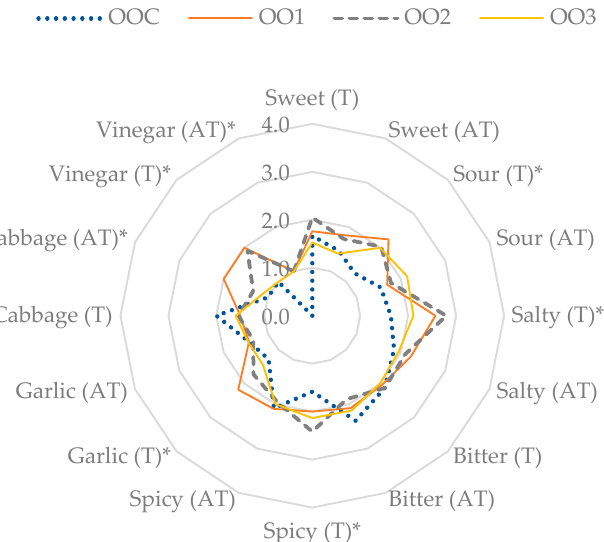
Figure 2. Sensory attributes of taste (T) and aftertaste (AT) of salt and equivalent salt of sauerkraut juice powder in samples with olive oil. * These tastes and aftertastes represent significant differences ( p ≤ 0.05).